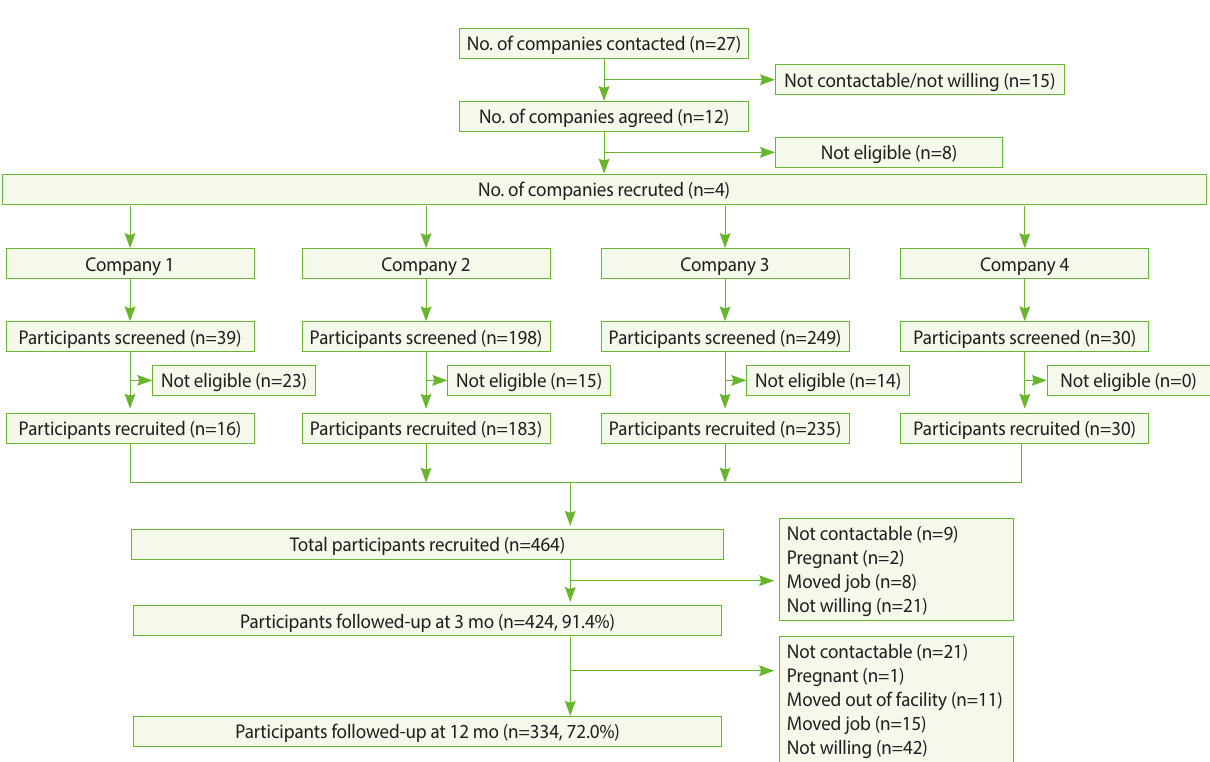
Figure 1. Flowchart showing the selection of study sites and participants, and